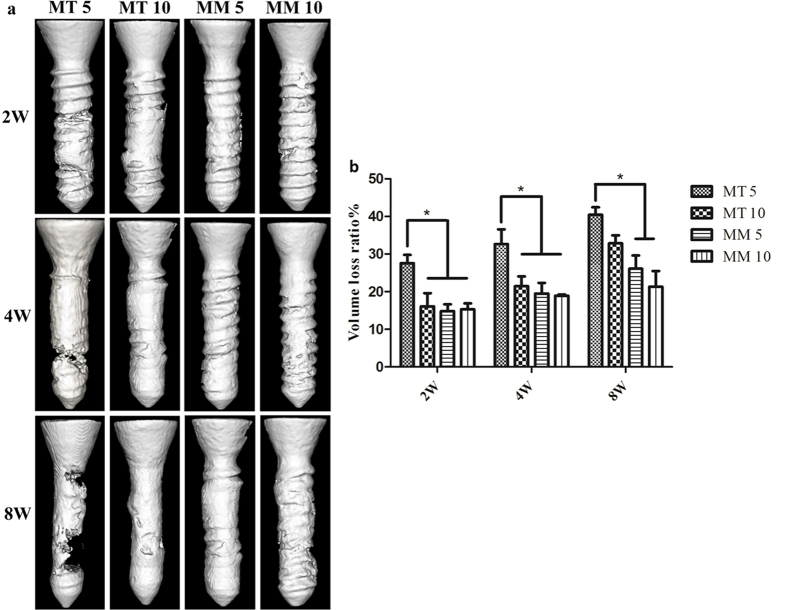
3D reconstruction (a) and volume loss percentage (b) of HP Mg screws in different groups. *p < 0.05.